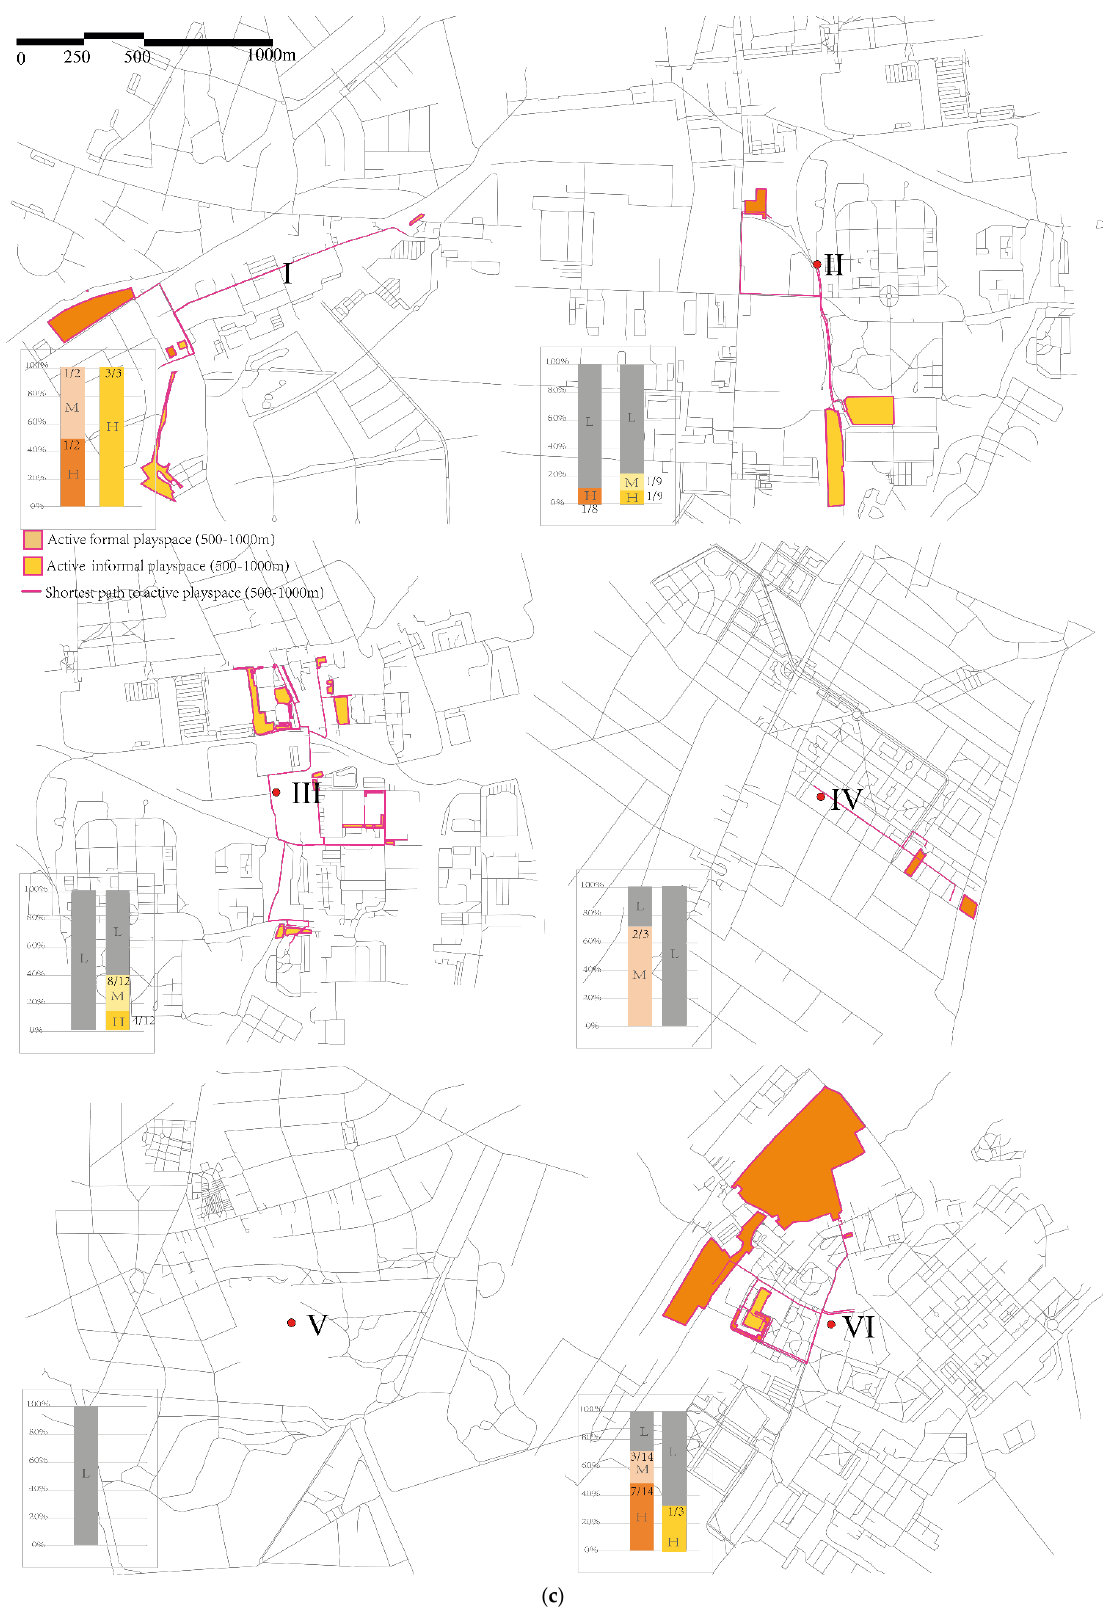
Figure 8. ( a ) Accessible playspace located in the top 20% of all investigated road segments in the depth map views; Global integration and active playspaces of six study sites: ( b ) under 500 m; ( c ) 500–1000